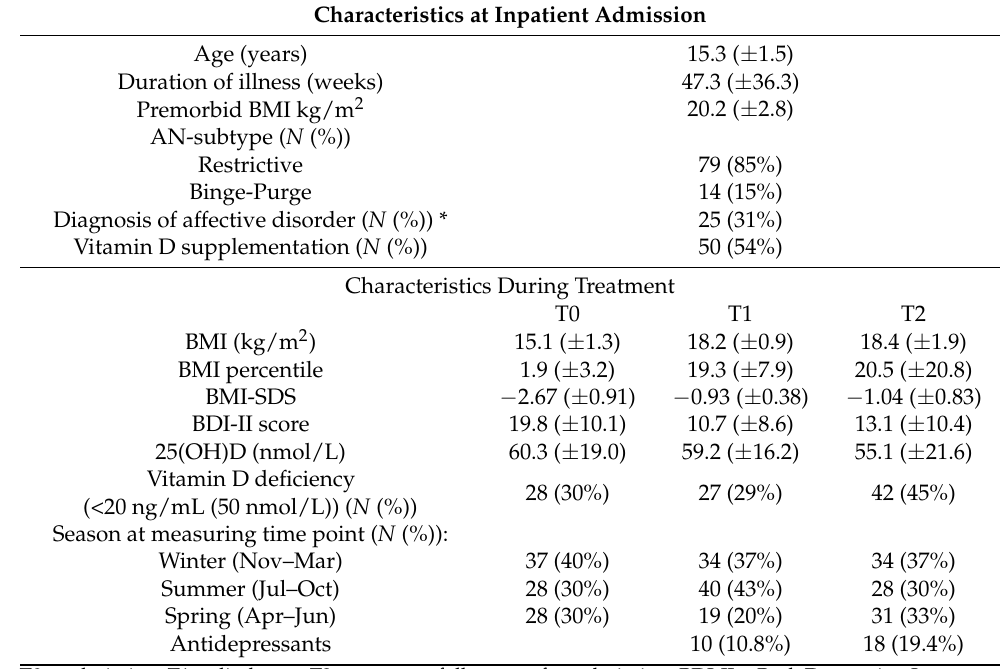
Table 1. Sample characteristics of the patients ( N = 93) with AN at respective measuring time points. Values are means ± SD or N (%) as